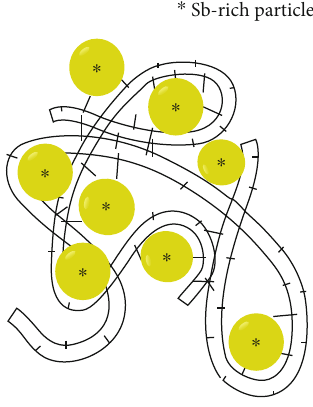
Scheme 3: Schematic representation of fl occulation.